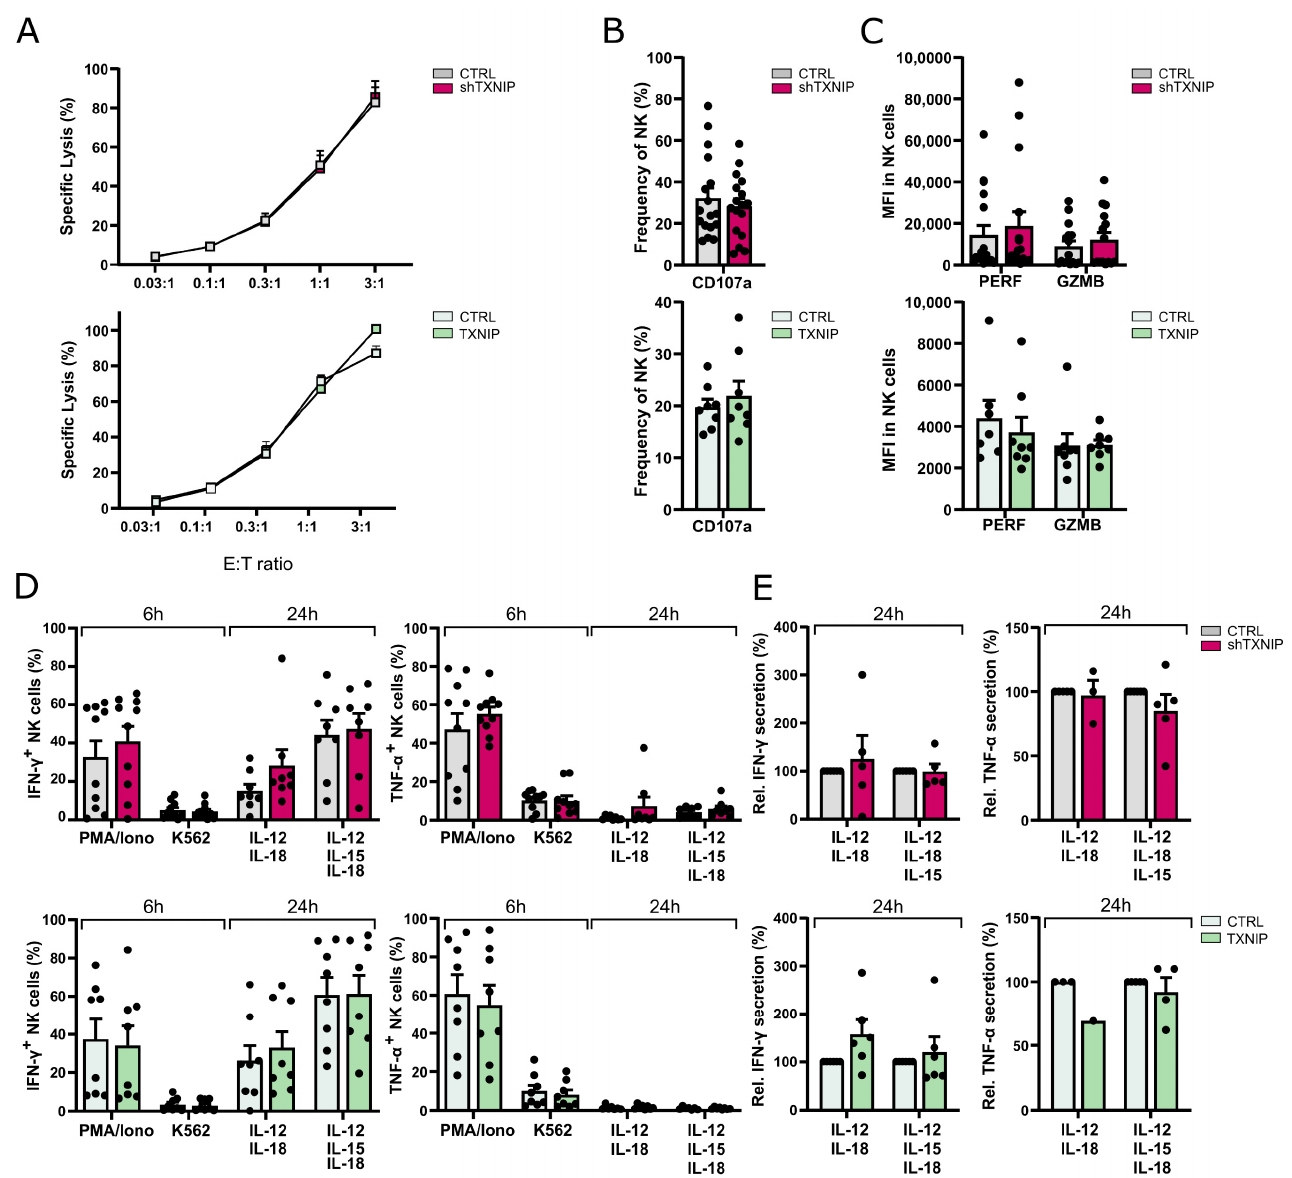
Figure 6. Dispensable role for TXNIP in NK cell functionality. The functionality of NK cells of TXNIP knockdown and overexpression conditions was examined on day 21 of culture. ( A ) NK cell cytotoxicity was assessed using a 51-chromium release assay. NK cells (eGFP + CD45 + CD56 + CD94 + ) were sorted and incubated for 4 h with K562 target cells at the indicated effector to target (E:T) ratio. The percentage of specific target cell lysis is shown (mean ± SEM; n = 3–11). ( B ) NK cell degranulation was measured by flow cytometric analysis of CD107a cell membrane expression in NK cells (eGFP + CD45 + CD56 + CD94 + ) after 2 h incubation with K562 target cells at a 1:1 E:T ratio (mean ± SEM; n = 8–17). ( C ) Expression (MFI) of the cytotoxic mediators perforin (PERF) and granzyme B (GZMB) in NK cells (CD45 + CD56 + CD94 + ) (mean ± SEM; n = 8–16). ( D ) IFN- γ and TNF- α production was analyzed with flow cytometry in gated NK cells after stimulation of bulk cells with PMA/Ionomycin or by coculture with K562 cells for 6 h, or after 24 h stimulation with either IL-12 plus IL-18 or IL-12, IL-15, and IL-18. Brefeldin A was added during the last 4 h of stimulation (mean ± SEM; n = 7–10). ( E ) NK cells (eGFP + CD45 + CD56 + CD94 + ) were sorted and stimulated with IL-12 plus IL-18 or IL-12, IL-15, and IL-18. After 24 h, the supernatant was harvested, and IFN- γ and TNF- α secretion were analyzed by ELISA. Cytokine secretion is reported as mean percentage relative to the control condition (set at 100%) (mean ± SEM; n = 1–6).